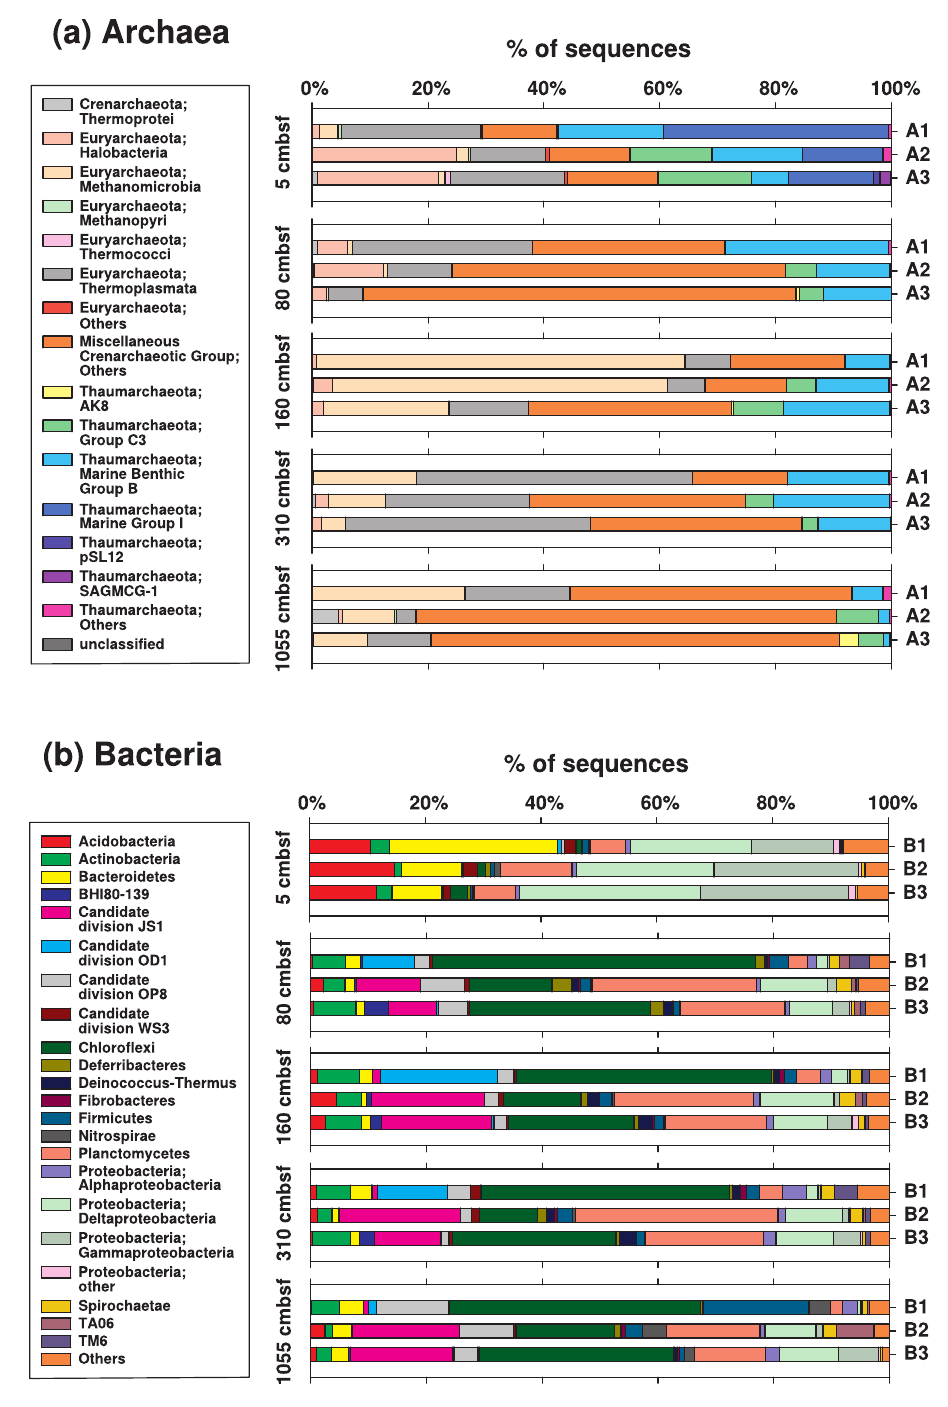
Figure 5. Archaeal and bacterial community compositions in the bioturbation zone (5 cmbsf), the sulfate zone (80 cmbsf), the SMTZ (160 cmbsf), the shallow methane zone (310 cmbsf), and in a freshwater peat layer within the deep methane zone (1055 cmbsf) at M1. Archaeal 16S gene libraries were produced using the primer pairs A1 (Arc806F - Arc958R), A2 (Arc806F - Arc915Rmod), and A3 (Arc915Fmod - Arc1059R), while the bacterial libraries were produced using the primer pairs B1 (Bac8F - Bac338Rabc), B2 (Bac806F_mod2 - Bac908R), and B3 (Bac908F - Bac1075R). Operational Taxonomic Units (OTUs; 97% cutoff) were assigned to class level for Archaea and to phylum level for Bacteria using Mothur, based on an alignment of amplicons to the 16S rRNA reference sequences in SILVA Release 119. See Supplementary Methods for more